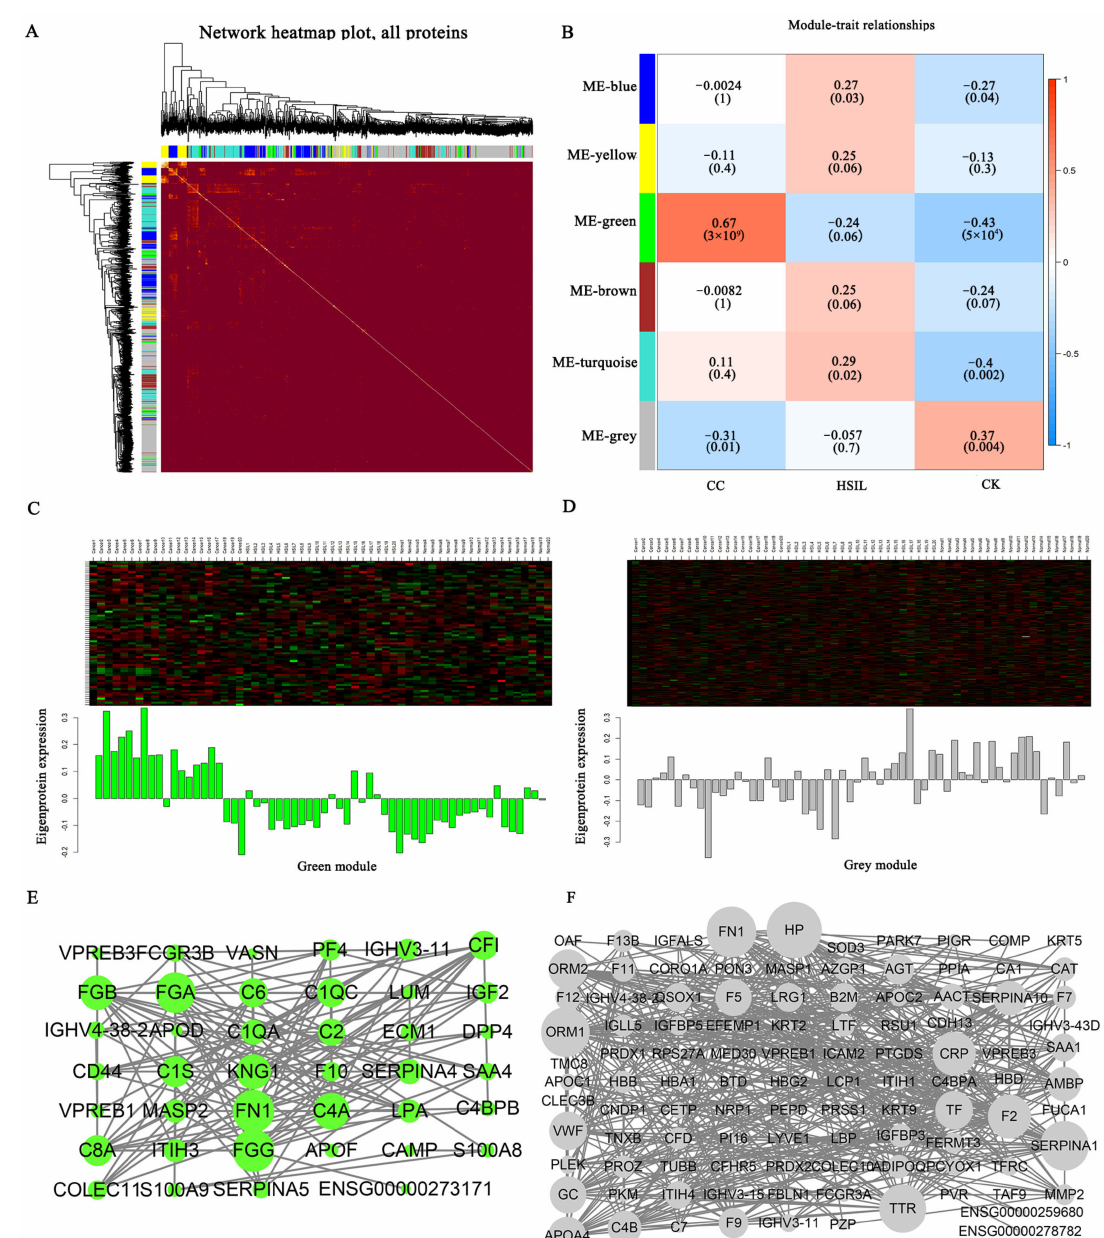
Figure 7. WGCNA analysis of DEPs. ( A ) Heat map of the visualized protein network. The heat map depicts the difference between all DEPs in the analysis. Light colors indicate low overlap and dark colors indicate high overlap. ( B ) A total of six co-expression modules were constructed, and each color represents one module of the protein co-expression network constructed by WGCNA. The top numbers in each cell represent Pearson r, and the bottom numbers represent p -values. ( C ) Trend of green module protein expression. ( D ) Trend of gray module protein expression. ( E ) PPI network of green module. ( F ) PPI network of gray